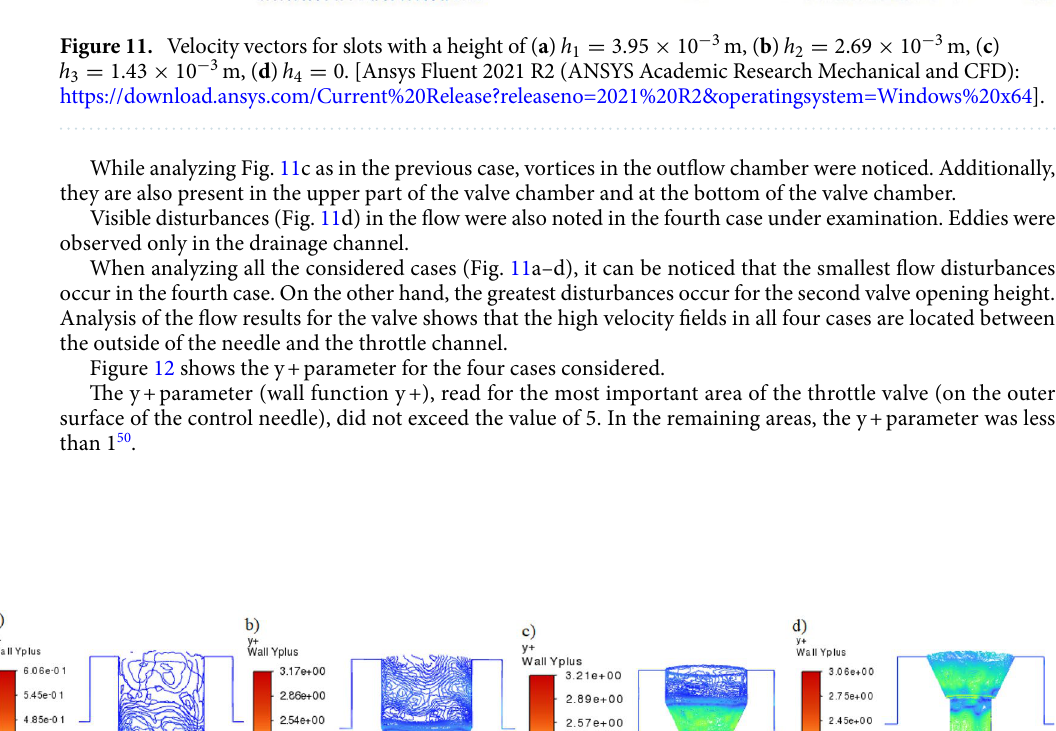
3 m, ( b ) h 3.95 10 − = ×